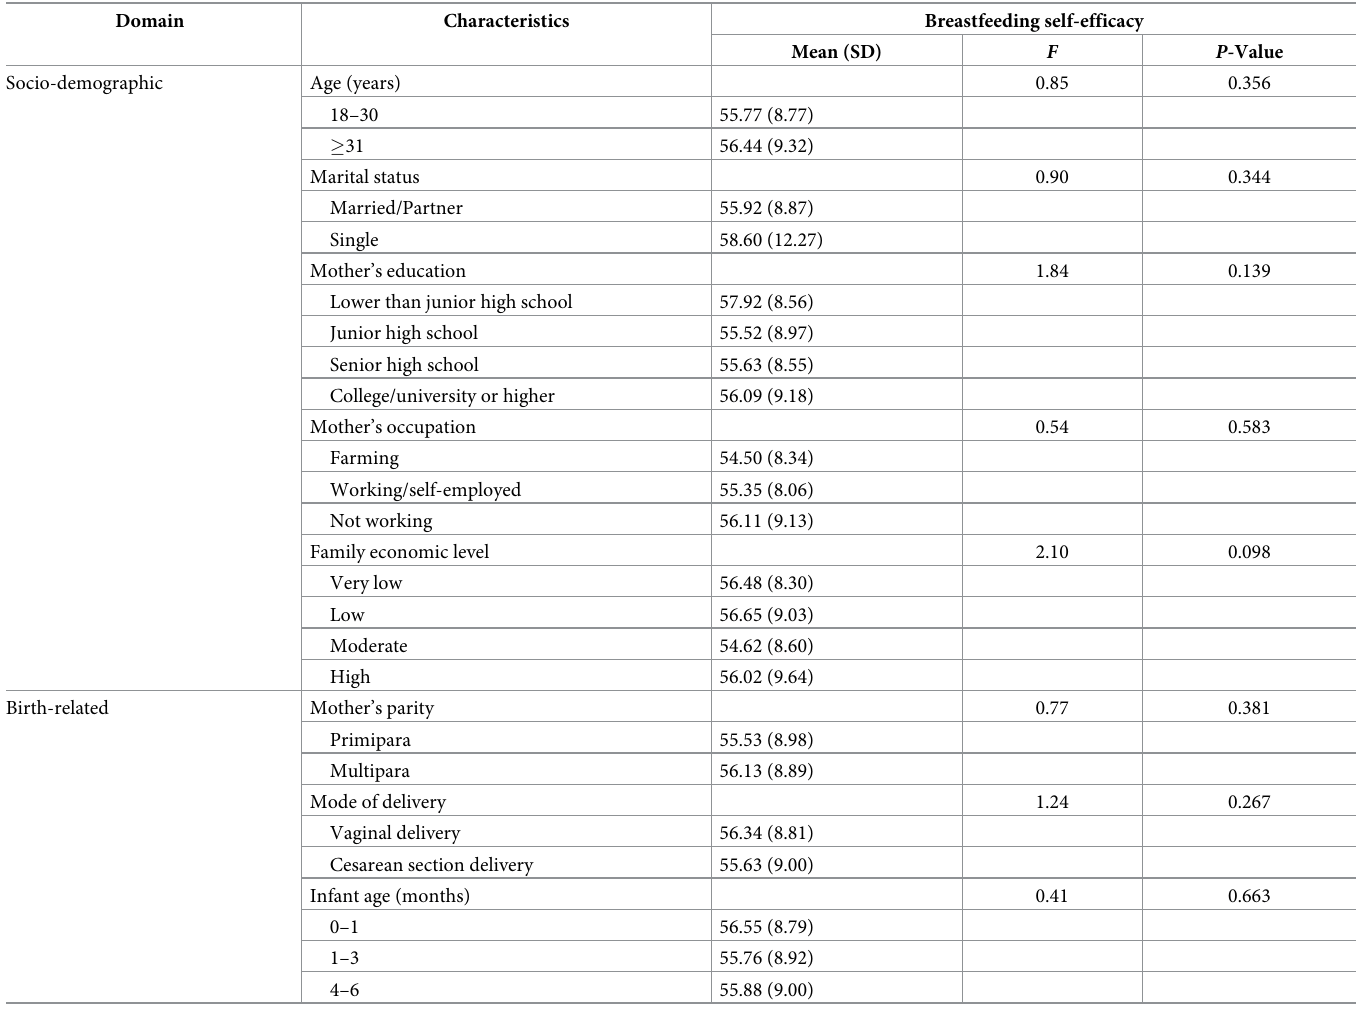
Table 3. Differences in breastfeeding self-efficacy among various demographic sub-groups (N = 787).